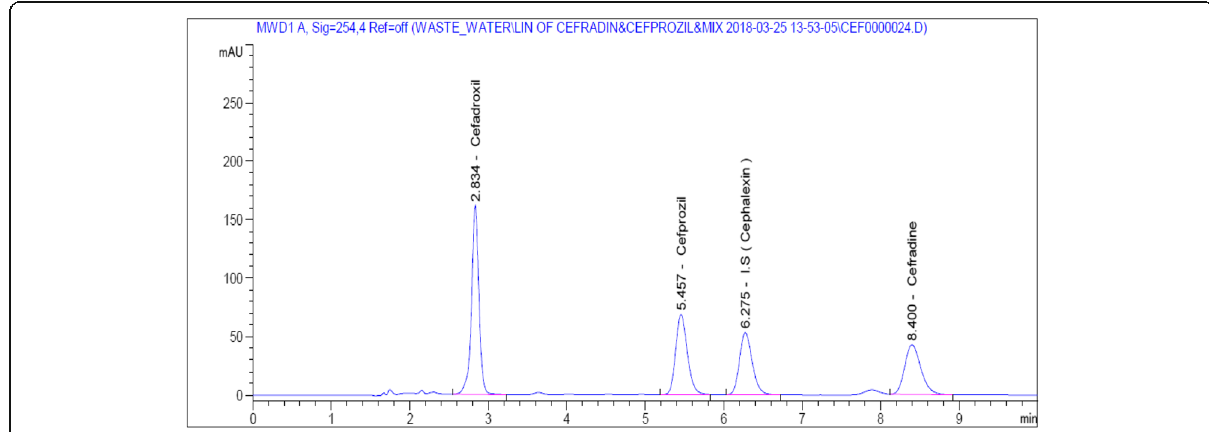
Fig. 2 Chromatogram of separation of cefadroxil, cefprozil, and cefradine using acidified water (pH 2.5) to methanol to acetonitrile (82:12:6, v / v ), with acid as a mobile phase and cephalexin as the internal standard